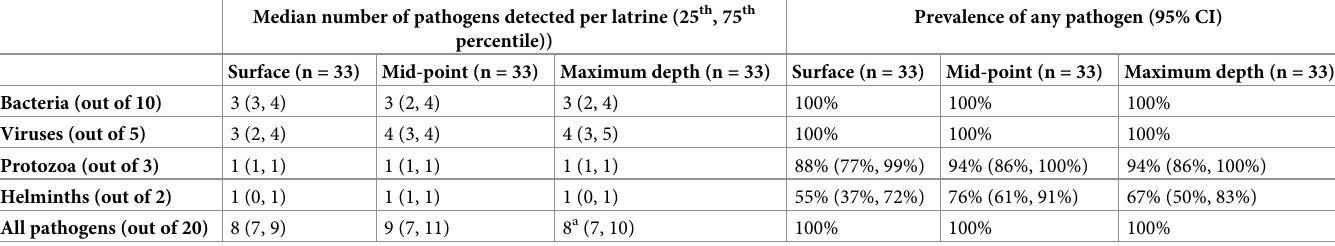
Prevalence of any pathogen (95%